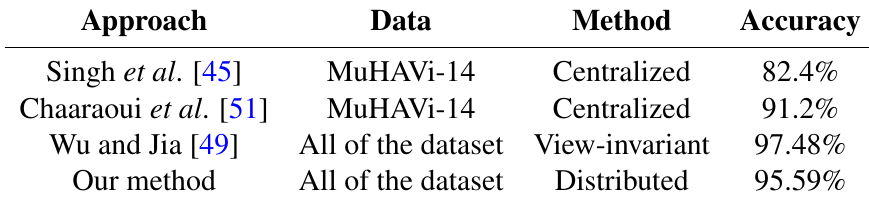
Table 2. Overall accuracy results on the MuHAVi dataset. The data column shows the subset of the data used for evaluation for each of the